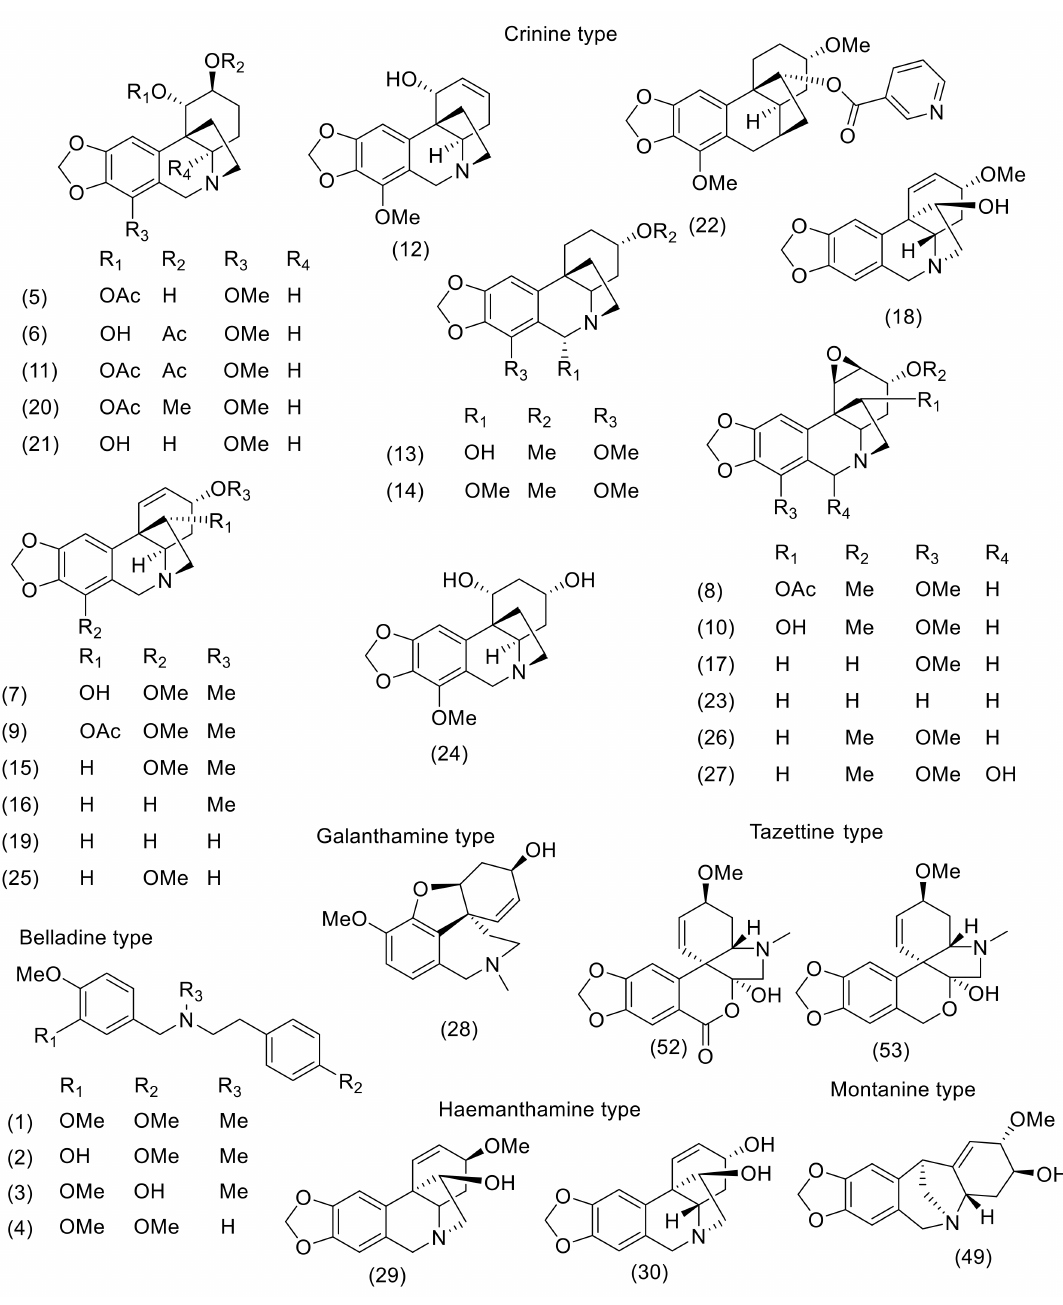
Figure 2. Amaryllidaceae alkaloids of crinine-, galanthamine-, belladine-, tazettine-, haemanthamine, and montanine-type reported in Nerine